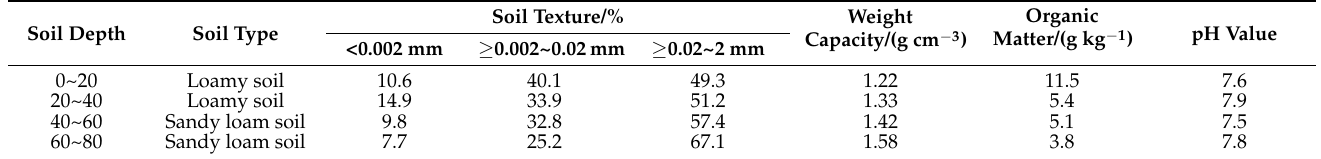
Table 1. Soil characteristics of the test site.